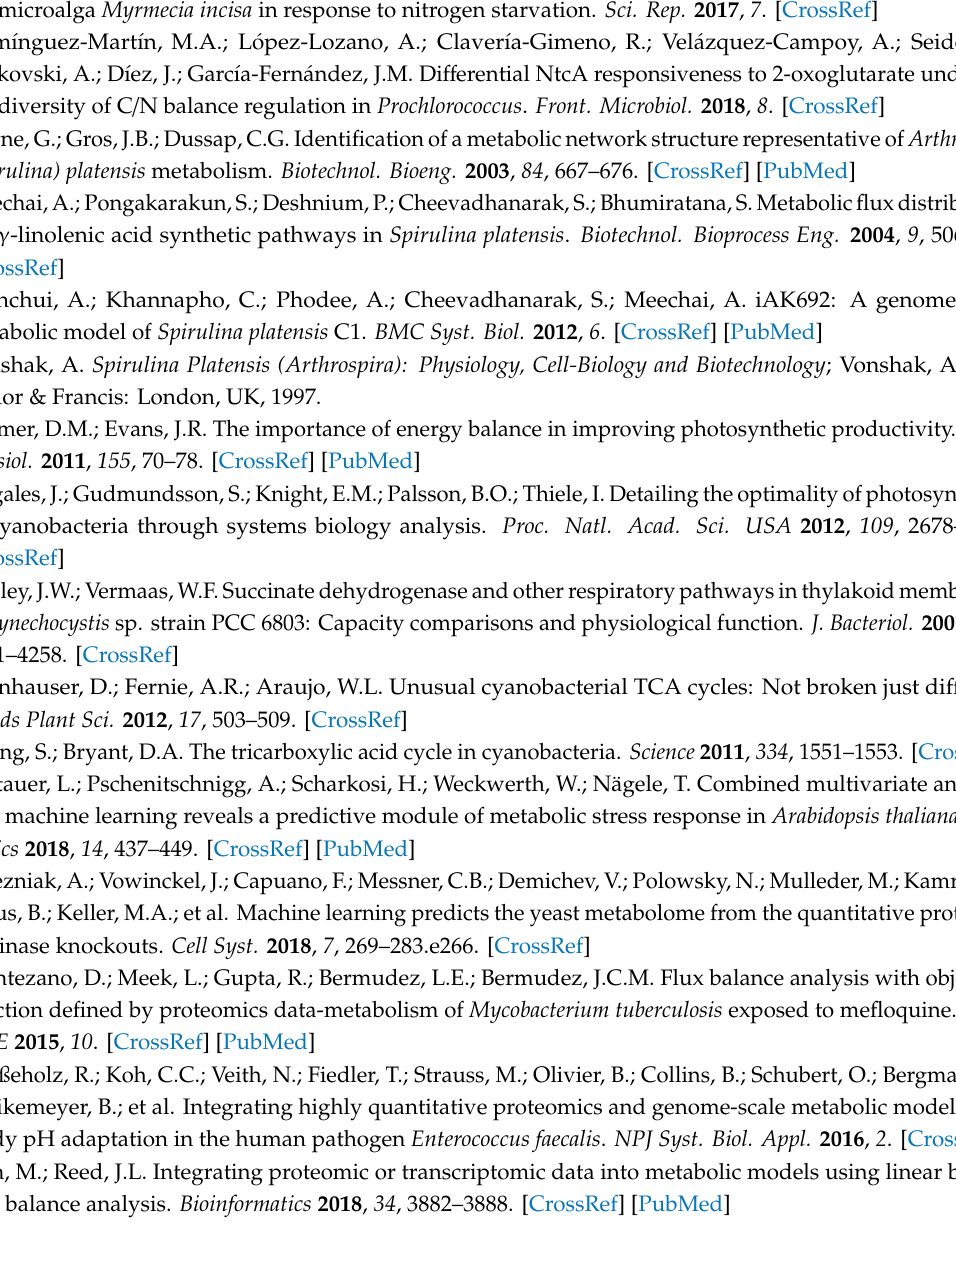
Table S4: Classification of reactions into catabolism and anabolism, Table S5: Ratio of the relative % of a ff ected reaction in the carbon and nitrogen metabolism under / of each condition / in silico